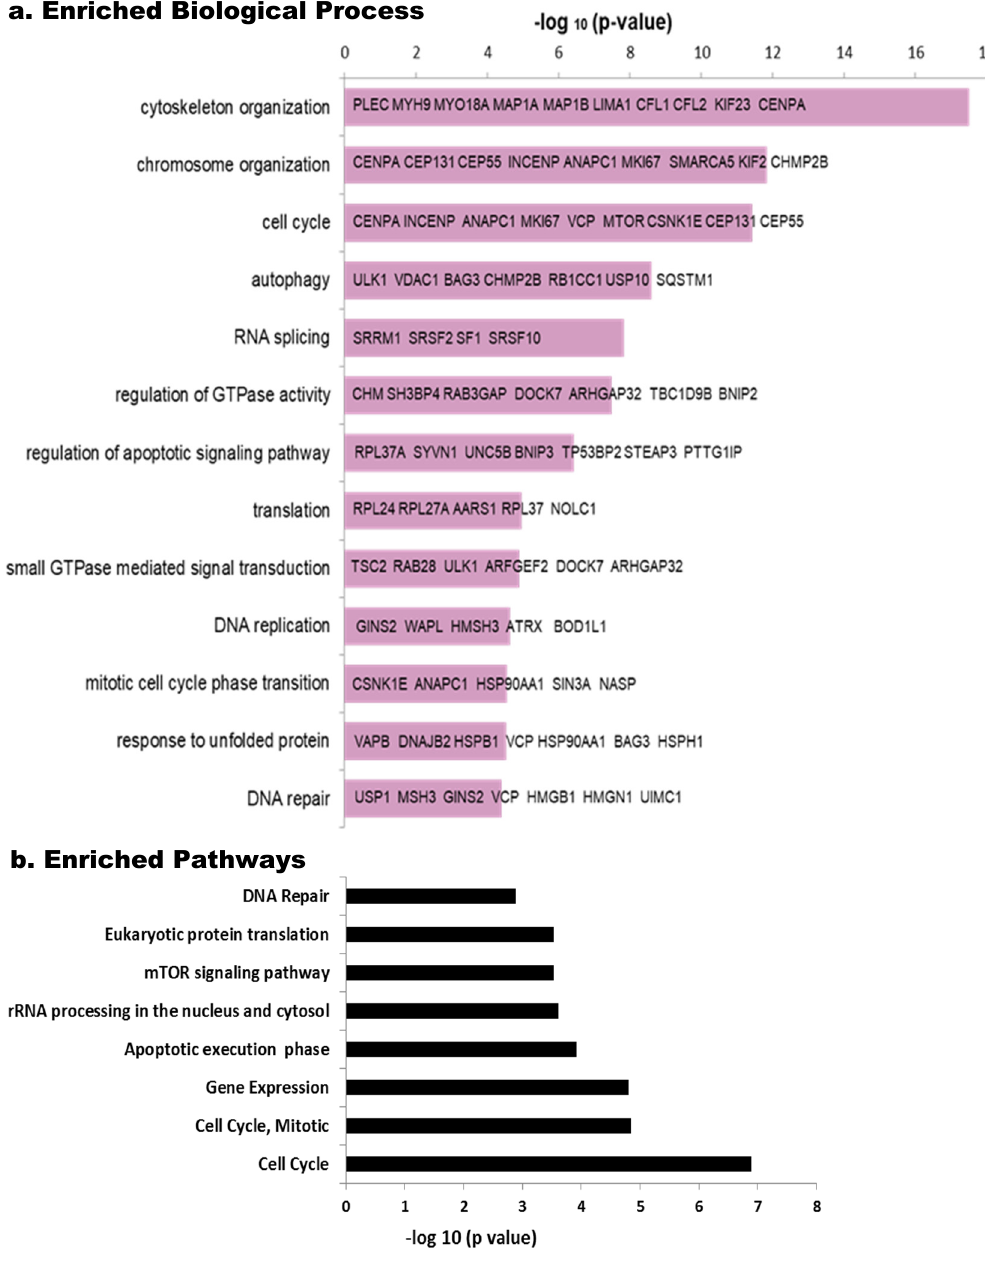
Figure 3. Enriched Biological processes and Pathways in phospho-proteomic data using the Toppfun tool. The reciprocal of Log (p) is tabulated for each Biological Process ( a ) and Pathway ( b ). Some of the principal components of the Biological Processes are shown in bars, as gene symbols.